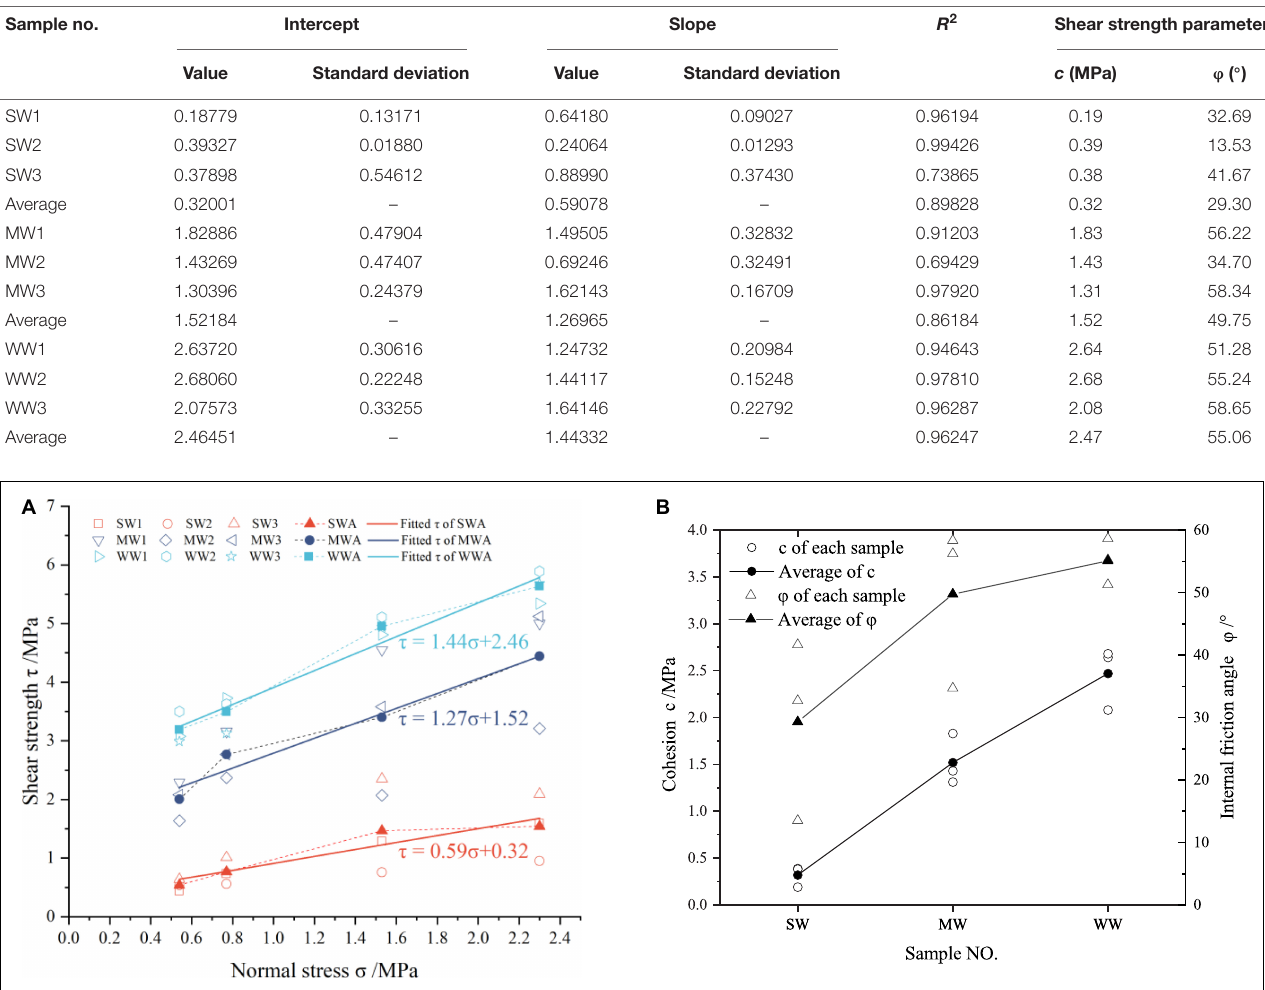
TABLE 2 | Shear strength parameter of weathered diorite–porphyrite samples according to the Mohr–Coulomb criterion. Sample no.